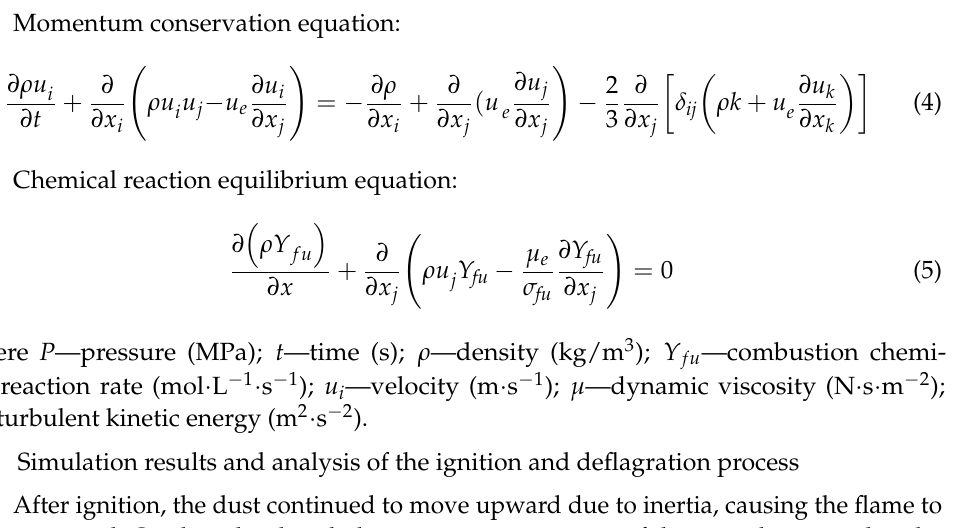
100ms Figure 10. Temperature change after ignition. It can be seen from Figure 11 that the dynamic pressure spreads to the surrounding area after powder spraying and then decreases to nothing. After ignition, the dynamic